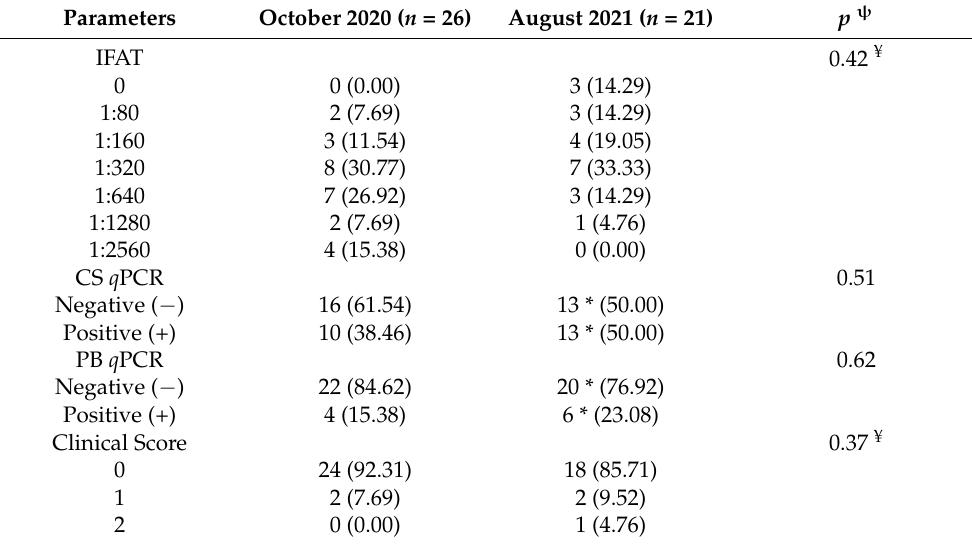
Table 4. Comparison between October 2020 and August 2021 in dogs enrolled in the study. Parameters